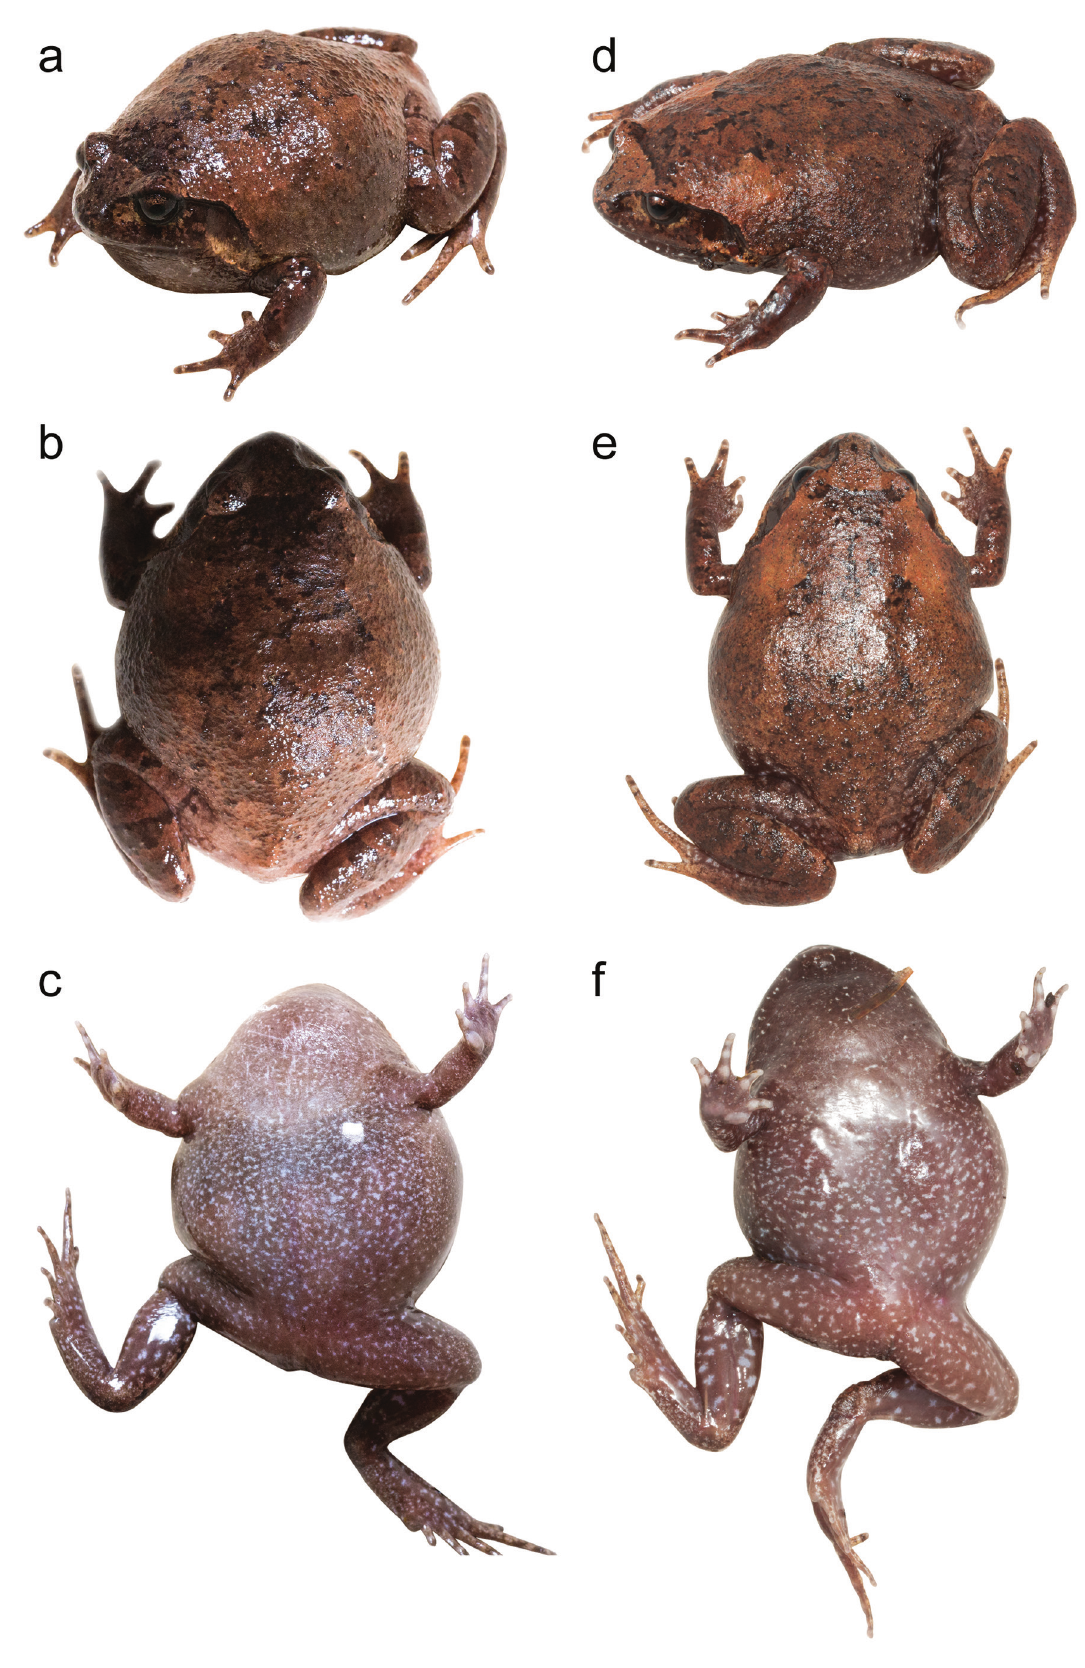
Figure 3. Photos in life of Rhombophryne nilevina sp. n . ( a ) Dorsolateralview of the holotype (KU 340893). ( b ) Dorsal view of the holotype. ( c ) Ventral view of the holotype. ( d ) Dorsolateral view of the paratype (CRH 799, UADBA-A Uncatalouged). ( e ) Dorsal view of the paratype. ( f ) Ventral view of the